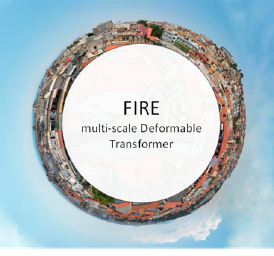
Figure 12. Fire misdetection of the FIRE-multiscale deformable transformer applied to 360-degree stereographic projections.